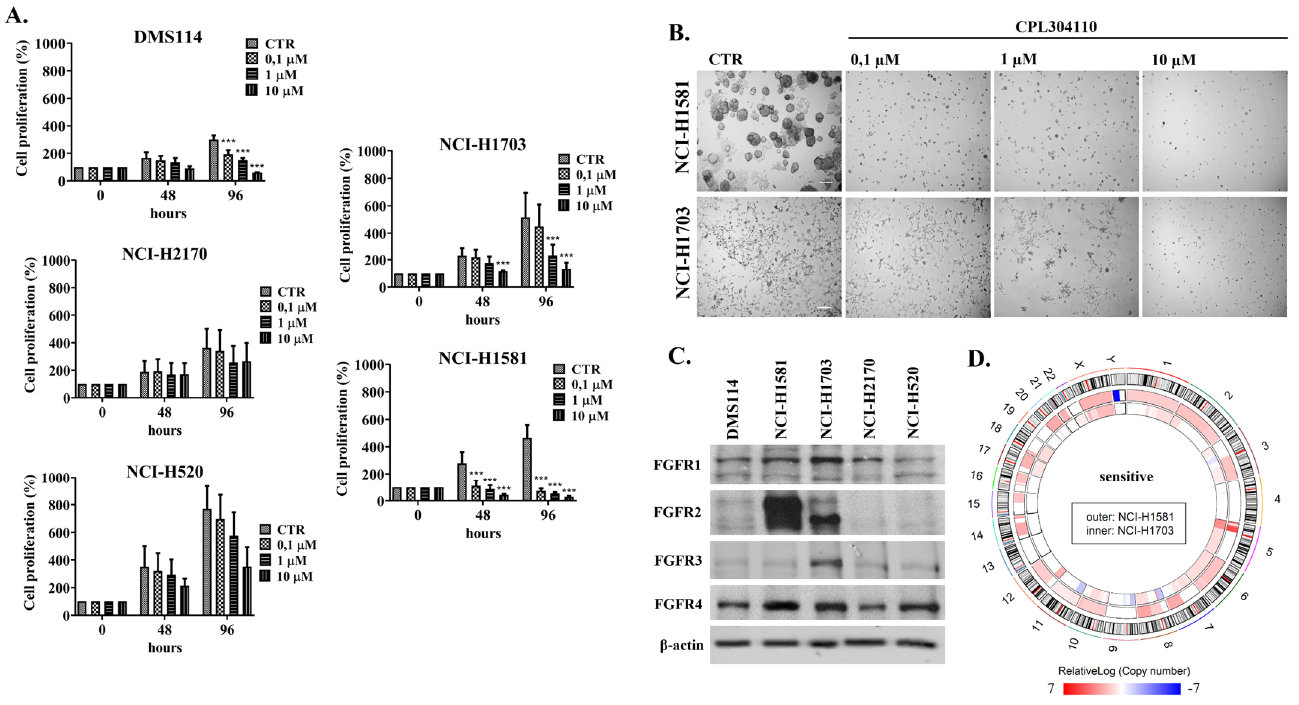
Figure 1. Lung cancer cell line response to a novel FGFR inhibitor. ( A ) DMS114, NCI-H1581, NCI-H1703, NCI-H2170, and NCI-H520 cell lines were exposed to the indicated CPL304110 concentrations for 48 and 96 h. The anti-proliferative effect of the inhibitor was assessed using the MTT cell viability test. Data are expressed as mean ± SD, *** p ≤ 0.001 compared to non-treated cells, n = 3. ( B ) NCI-H1581 and NCI-H1703 cells were grown in 3D BD Matrigel ® for 14 days in the presence of CPL304110 in indicated concentrations. Representative pictures were taken. Scale bar represents 100 µ m, n = 3. ( C ) Western blot analysis of FGFR1-4 protein expression was performed for lysates of all five lung cancer cell lines. Experiments were conducted in triplicates. Representative blots are shown. ( D ) The circos plot depicts aCGH-derived DNA copy number profiles (relativeLog) of the analysed lung cancer cell lines. The outer circle represents chromosome cytobands (centromeres are shown as red bars) of the reference human genome GRCh38; middle and inner circle show a copy number changes in the NCI-H1581 and NCI-H1703 cells (respectively), in comparison to the reference genome. Numbers and letters on the outside indicate chromosomes.